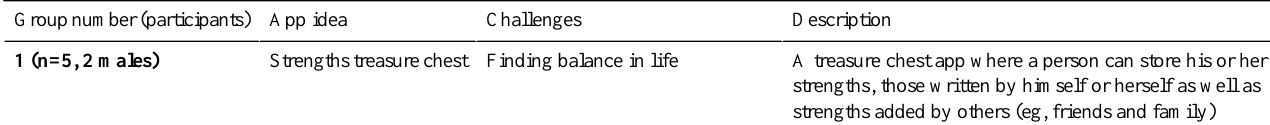
A treasure chest app where a person can store his or her strengths, those written by himself or herself as well